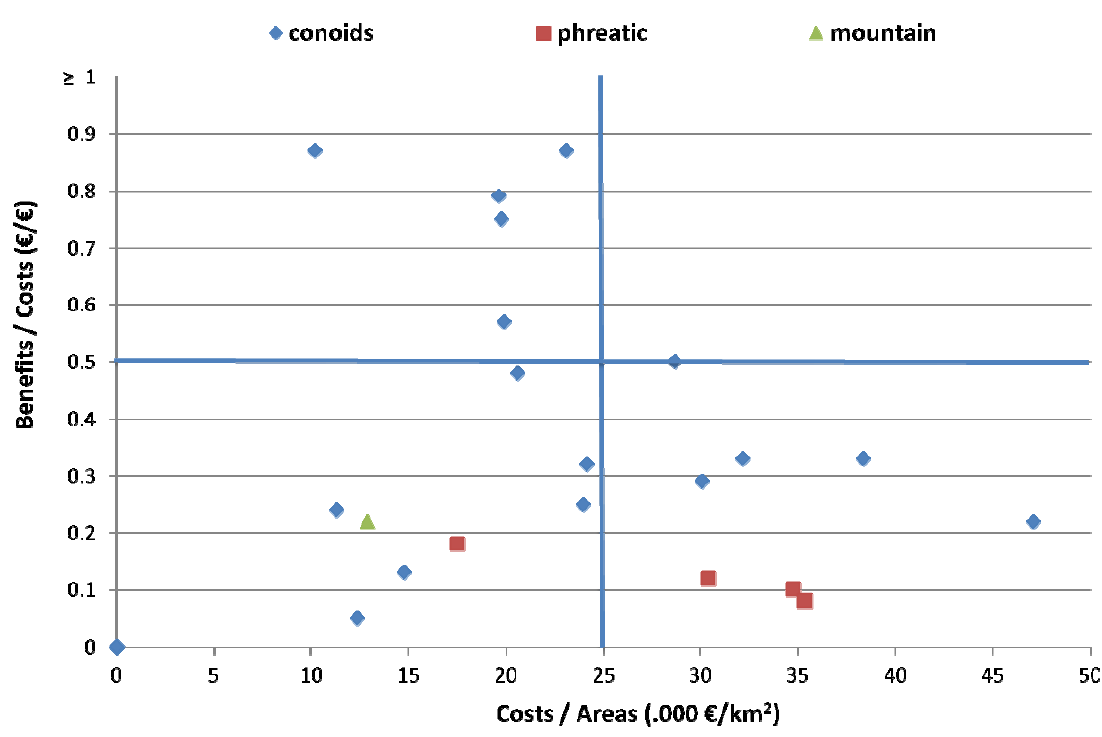
Figure 3. Crossing CBA indicators and CEA indicators at the level of aggregation of groundwater bodies: according to their location stratified with respect to the conoids, the phreatic aquifer area and the mountain